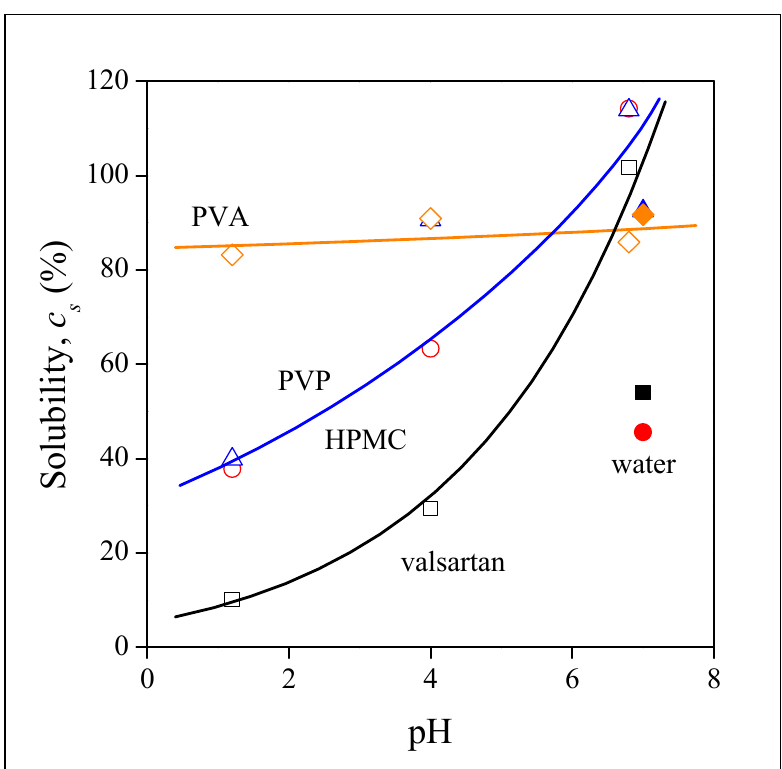
Figure 11. pH dependence of the equilibrium dissolution of neat valsartan and that of valsartan released from electrospun fibers prepared from different polymers. Symbols: (  ) neat valsartan, (  ) released from electrospun fibers prepared from different polymers. Symbols: ( (cid:3) ) neat HPMC, (  ) PVA, (  ) PVP; full symbols indicate dissolution into distilled water.